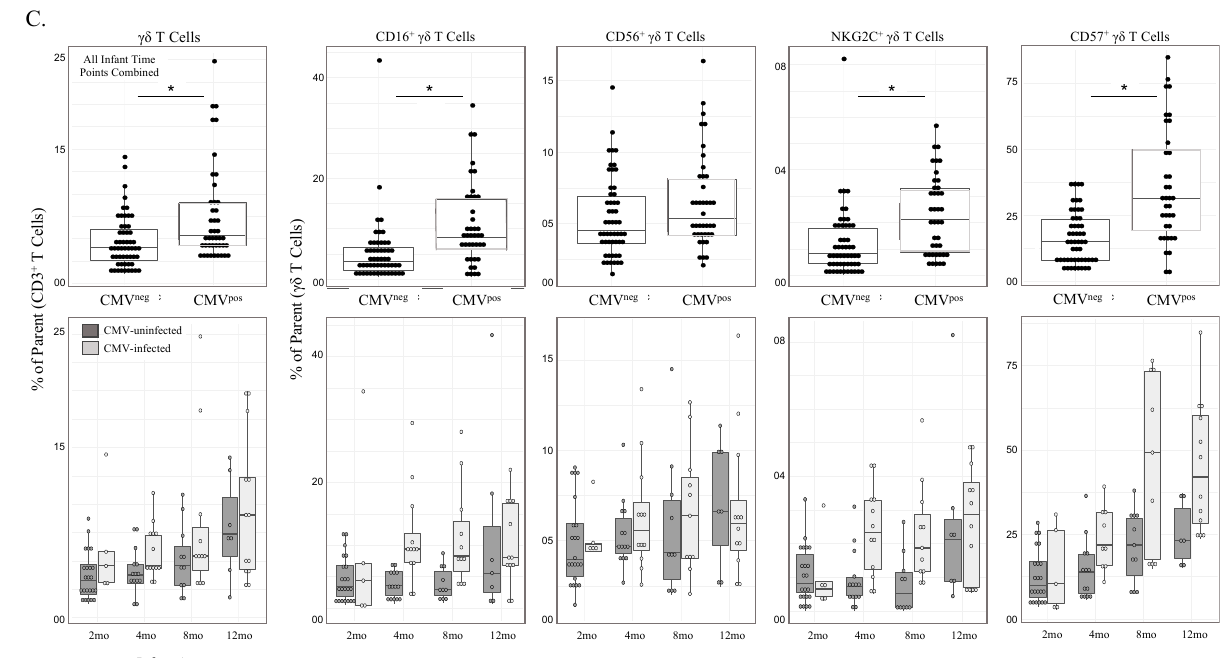
Figure 2. γδ T cell frequencies and phenotypic markers of activation increase with age and CMV infection. ( A ) Gating strategy for conventional flow cytometry panel. Initial flowCut cleaning in FlowJo was followed by singlet, lymphocyte, live and CD3 + gates as shown. γδ T cells were then gated as either CD16 + , CD56 + , NKG2C + and CD57 + . Positive gates were set using an internal positive biological control with known expression levels; ( B ) Total γδ T cells and CD16 + , CD56 + , NKG2C + and CD57 + γδ T cells grouped by age. Infants (2, 4, 8 and 12 months of age), children (1–2 and 2–8 years old) and adult mothers were stratified by HIV serostatus (HIV-infected n = 17, HIV-uninfected n = 15); ( C ) γδ T cells from CMV-infected ( n = 20) and CMV-uninfected infants ( n = 8). Top row depicts cell frequencies in longitudinal samples from CMV-infected ( n = 43) and CMV-uninfected ( n = 57) infants (all time points) and the bottom row represents the same data plotted by both CMV infection and age in months. A mixed methods linear regression model accounting for repeated measures and testing for age, sex and HIV exposure in utero was used to determine statistical associations. Horizontal bars represent the median; boxes extend to the 25th and 75th percentile and whiskers represent the 95th percentiles. p -values were adjusted for multiple comparisons (each cell population tested); one asterisk (*) indicates p < 0.05, three (***) indicates p < 0.001.